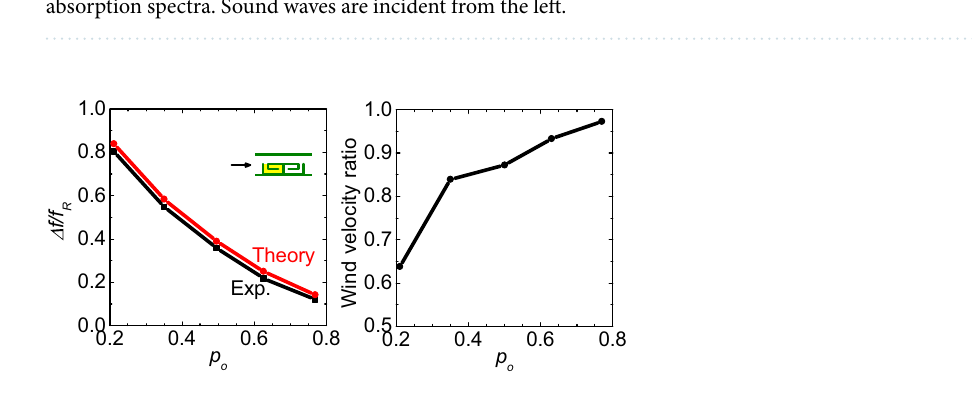
Figure 7. ( a ) Relative absorption bandwidths � f / f R and ( b ) measured wind velocity ratio as a function of open area ratio p o